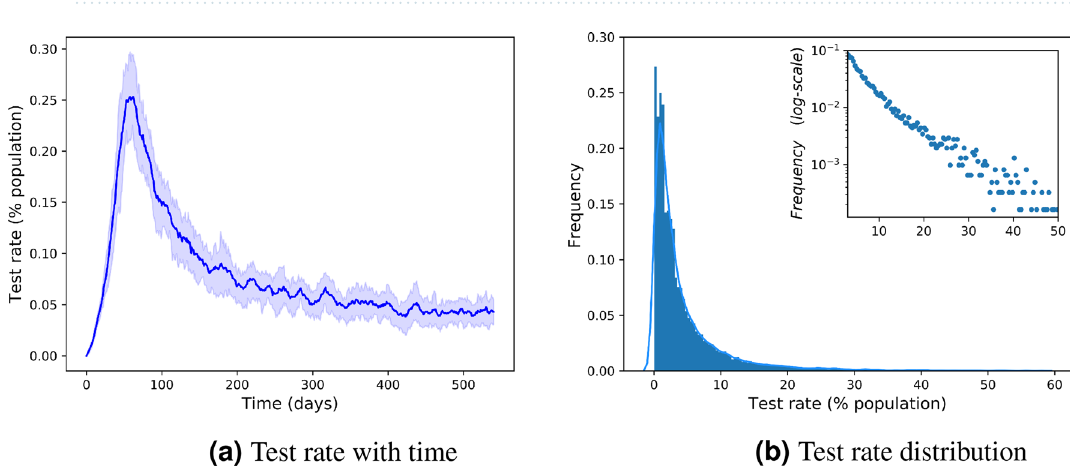
Figure 8. Distribution of test rates of the Track and Test